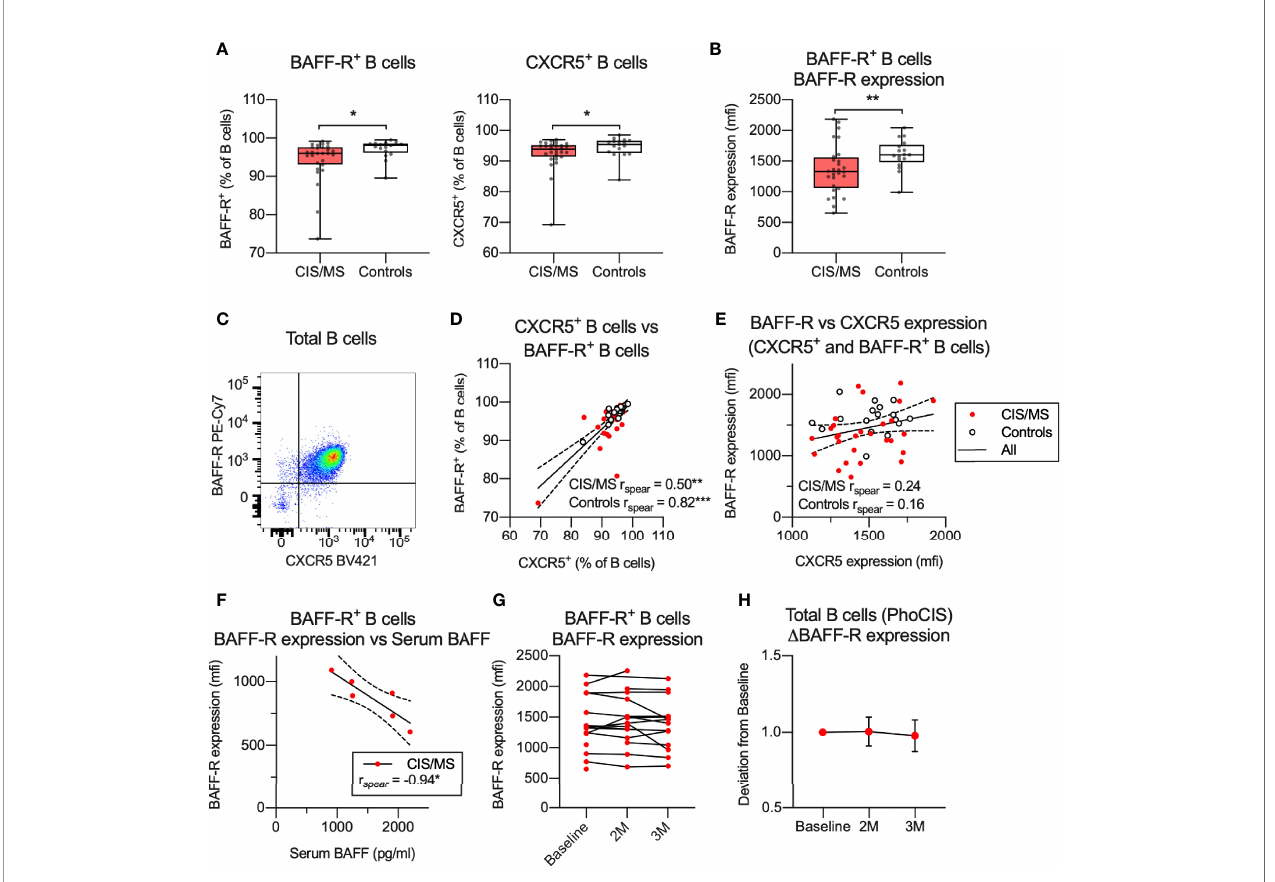
FIGURE 4 | (A, B) Abundance (A) or expression levels (B) of BAFF-R and/or CXCR5 on total or BAFF-R + B cells. (C) Expression of BAFF-R and CXCR5 on total B cells. (D) Correlation of BAFF-R + and CXCR5 + B cells in CIS/MS patients and controls. (E) Correlation of expression levels of BAFF-R and CXCR5 on BAFF-R + and CXCR5 + B cells in CIS/MS patients and controls. (F) Correlation of BAFF-R expression on BAFF-R + B cells and serum BAFF levels. (G, H) BAFF-R expression on BAFF-R + B cells at study recruitment and at 2 months (2M) and 3 months (3M) follow-up, displayed as raw data (G) or mean ± SD change from baseline (H) . Data in (A, B , D, E) are displayed for each participant, together with box/whiskers display for median and range where relevant (n CIS/MS = 28, n Controls = 17). Data in (C) is displayed from a representative individual and in (F) from a subset of individuals (n CIS/MS = 6). In (G, H) , data is displayed for (n Baseline = 15, n 2M = 15, n 3M = 14). Correlations are visualized using a linear fi t and 95% CI. Signi fi cance of difference between patient groups versus controls was calculated using Mann-Whitney non- parametric test on the raw data, correlation was calculated using Spearman non-parametric test and displayed as p<0.001, ***; p<0.01, **; p<0.05,